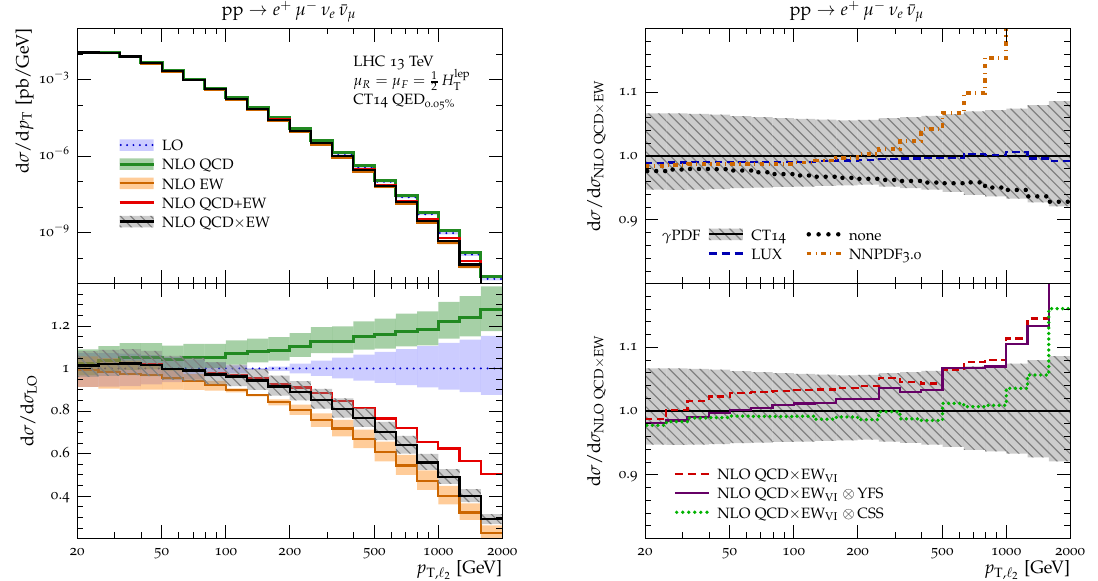
Figure 10 . Distribution in the transverse momentum of the subleading lepton, p T ;‘ 2 , for pp e + (cid:22) (cid:0) (cid:23) e (cid:22) (cid:23) (cid:22) at 13 TeV. Details as in (cid:12)gure 9. ! invariant mass of the e + (cid:22) (cid:0) pair, m ‘‘ . The leading and subleading lepton are de(cid:12)ned by their ordering in transverse momentum, irrespective of their charge. EW corrections to these observables feature the typical Sudakov behaviour, with small e(cid:11)ects below 100 GeV and large negative corrections at the TeV scale. In the tails of the lepton- p T and m ‘‘ distributions NLO EW corrections can reach and even largely exceed 50%. The dominant (cid:0) e(cid:11)ects originate from q (cid:22) q W + W (cid:0) topologies with resonant W bosons, and the strong ! enhancement of EW Sudakov corrections is induced by the high p T and the large SU(2) charges of the W bosons. In the presence of EW corrections of several tens of percent, (cid:12)xed- order NLO predictions should be supplemented by a resummation of Sudakov logarithms. As a rough indication of the possible magnitude of higher-order EW e(cid:11)ects, we observe